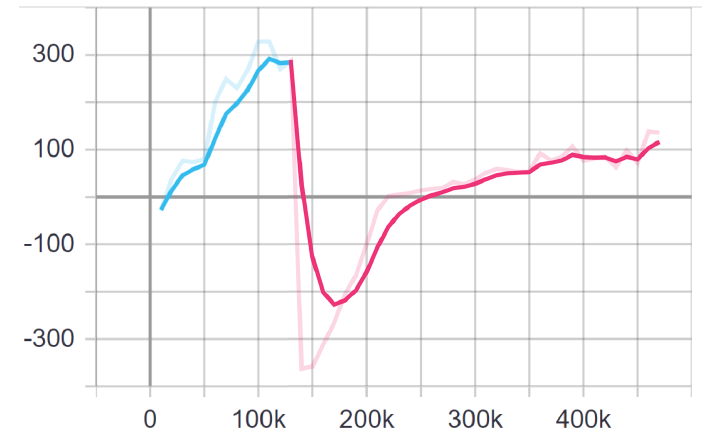
Figure 3. Cumulative reward of 2v2 training (Tensorboard).